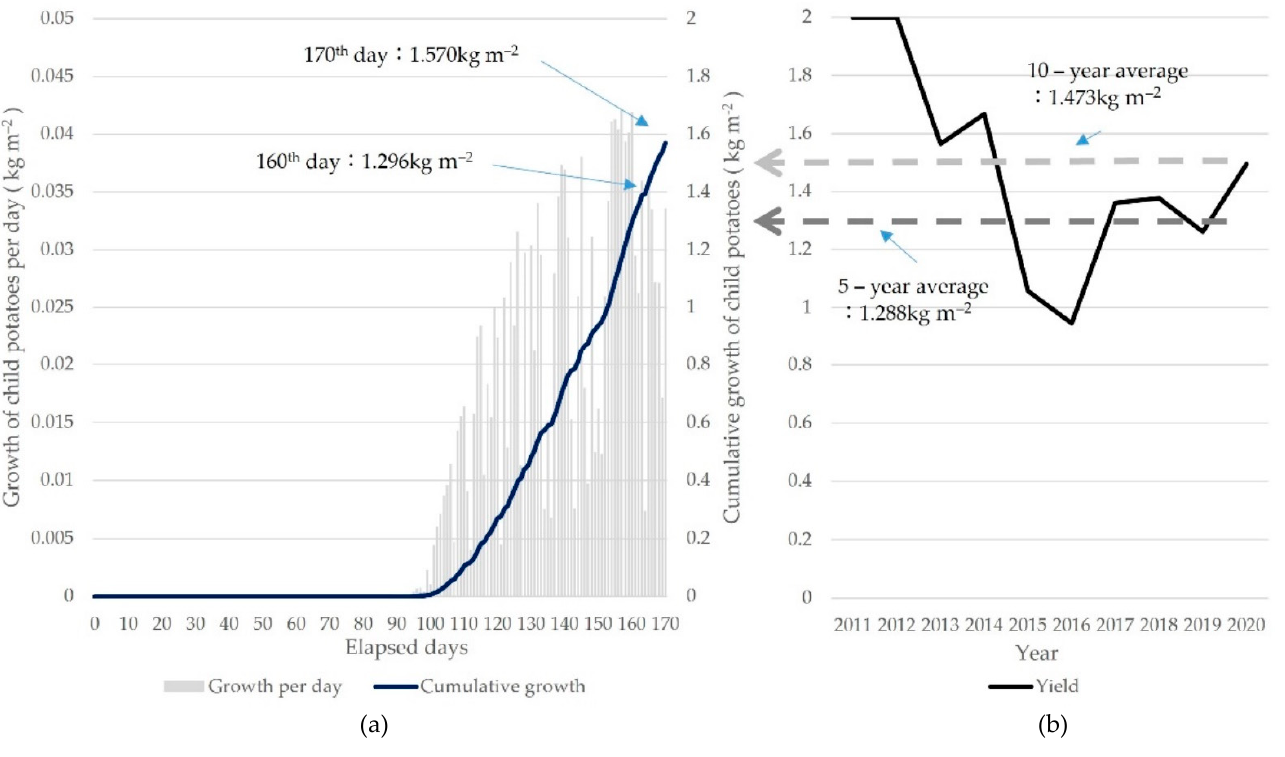
Figure 7. Comparison of taro yield using the model established by this study (a) and the actual yield in Miyazaki Prefecture (b).